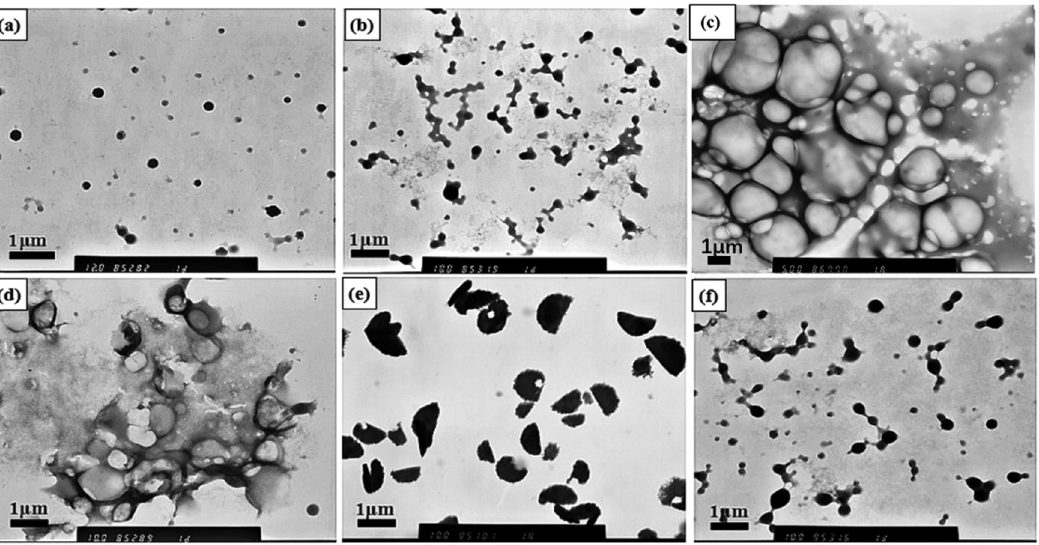
Figure 1: TEM images of aggregates formed from DSPE – PEG2k/MPEG – PDLLA mixtures with di ff erent mass ratios of DSPE – PEG2k/ PDLLA – MPEG: ( a ) 0:1, ( b ) 0.0005:1, ( c ) 0.001:1, ( d ) 0.005:1, ( e ) 0.01:1 and ( f ) 0.02:1.